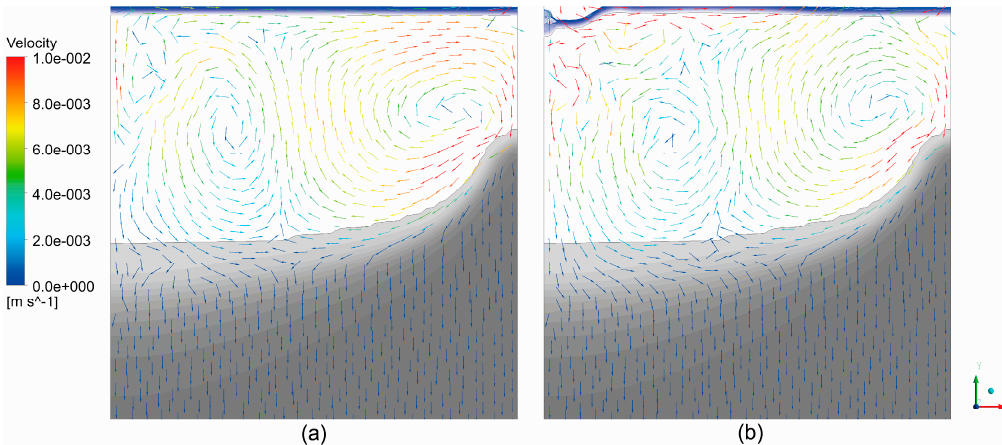
Figure 12. Typical map of velocity vector in liquid metal pool at 2485.65 s ( a ) and 2621.56 ( b ). The solidified ingot and mushy zone are marked in gray color.